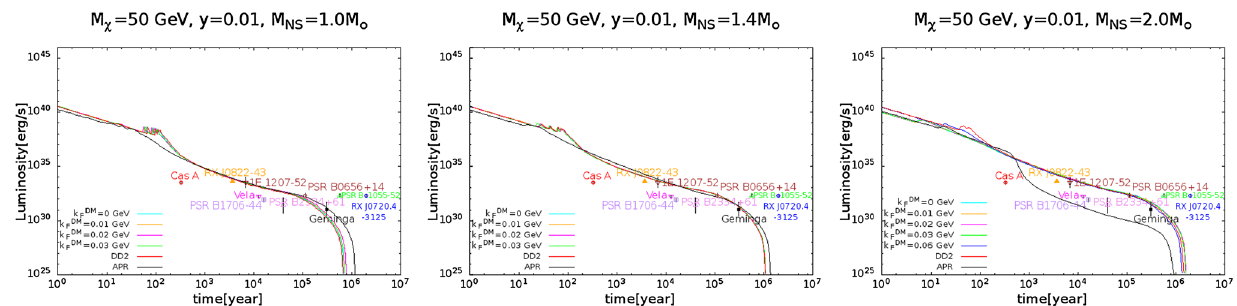
with the observational data of pulsars namely Cas A, RX J0822-43, 1E 1207-52, PSR B1706-44, Vela, PSR B2334+61, PSR B0656+14, and fixed F